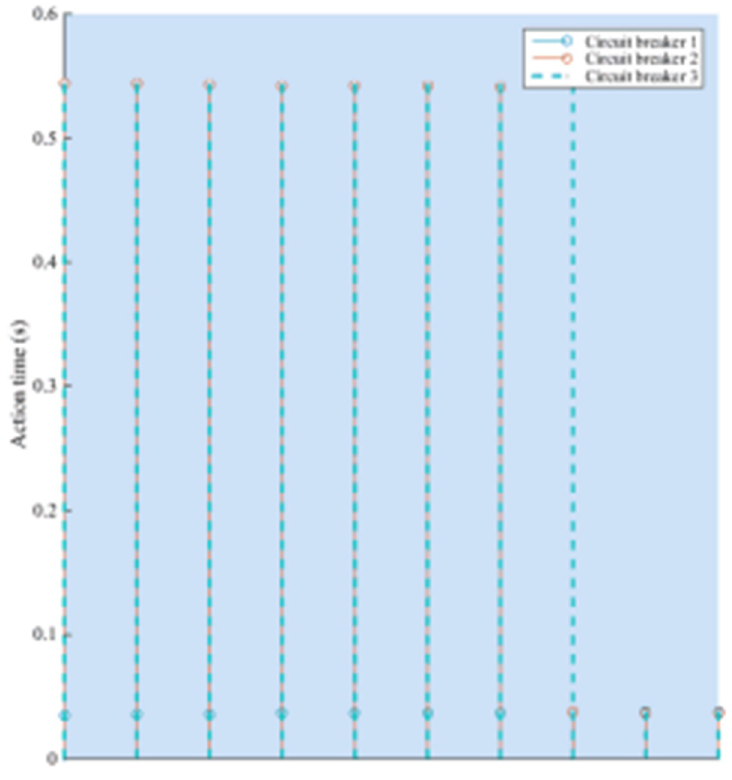
Fig 8. Analysis of protection action time on each